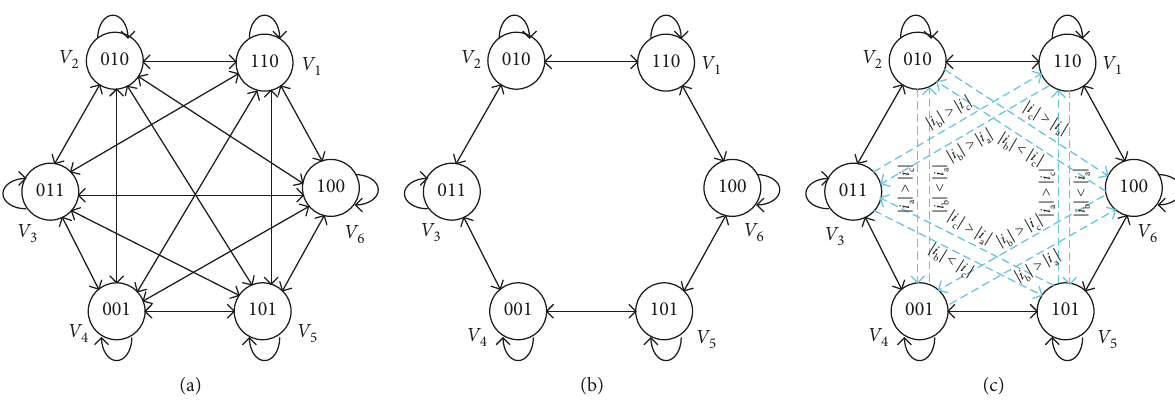
Figure 3: Switching state paragraph of the MPC-RCMV: the arrows define the possible changes of the switching states. (a) The 6VV strategy. (b) The 3VV strategy. (c) The 4VV strategy.